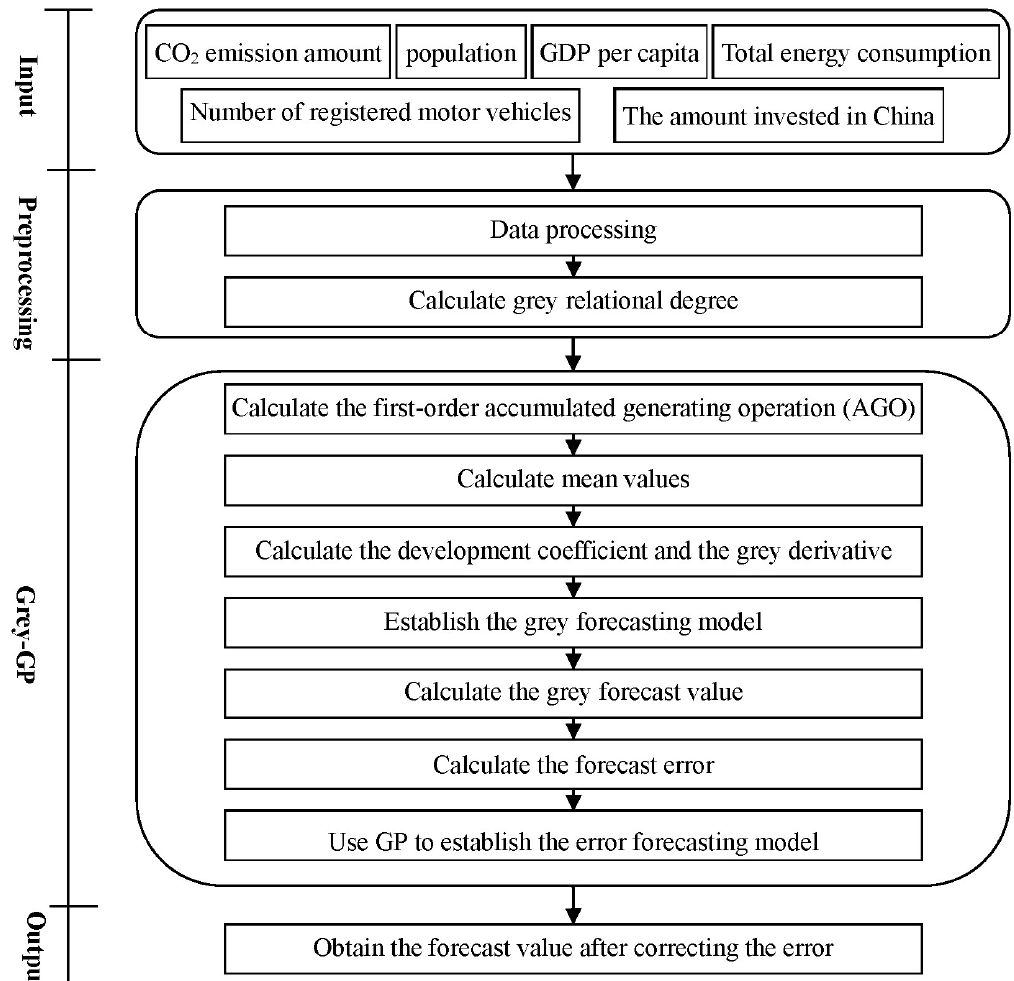
Figure 1. The framework of the proposed method.